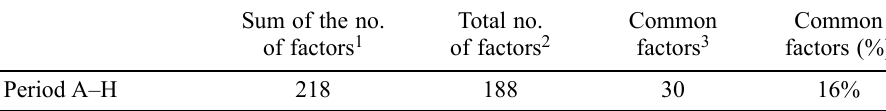
Table 4. Factor analysis. Resumptive explanatory results